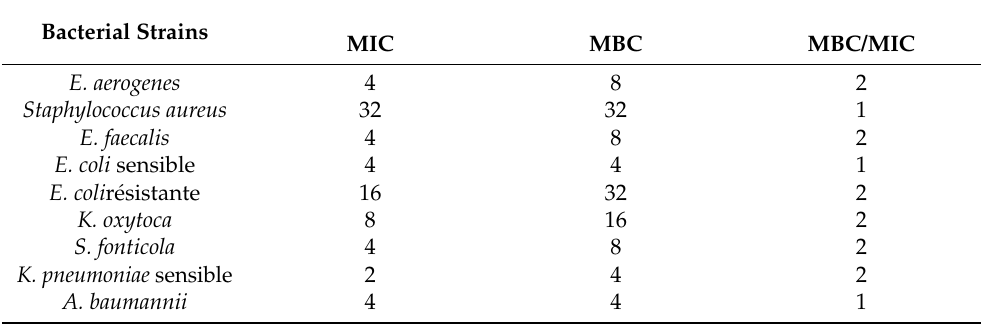
Table 4. Minimal inhibitory concentration (MIC), minimal bactericidal concentration (MBC), MBC/MIC report values ( µ L/mL) of O. elongatum